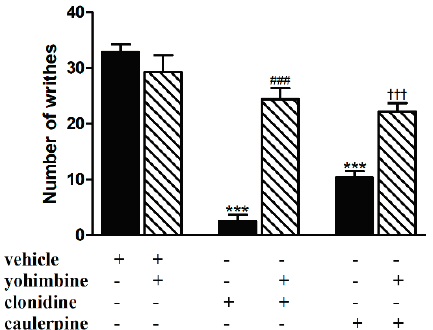
Figure 5. Effect of yohimbine on the antinociceptive effect of caulerpine in the acetic acid model of nociception. Black columns: treatments alone; hatched columns: pretreatment and treatments. The results are expressed as means ± S.E.M. of six animals. (One-way ANOVA followed by Bonferroni’s test). *** p < 0.001 compared to vehicle; ### p < 0.001 compared to clonidine; ††† p < 0.001 compared to caulerpine.